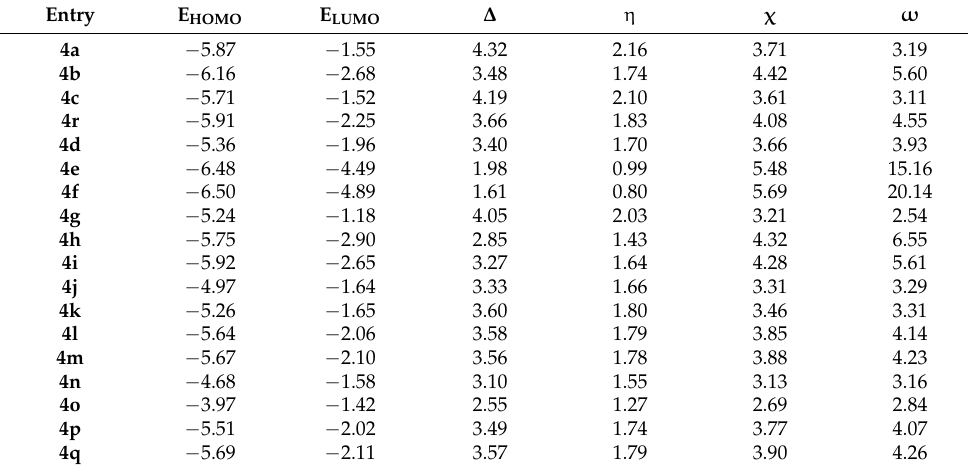
Figure 4. Computed molecular orbital plots for synthesized molecules 4k-4r with the counter value of 0.02 Å −3 .